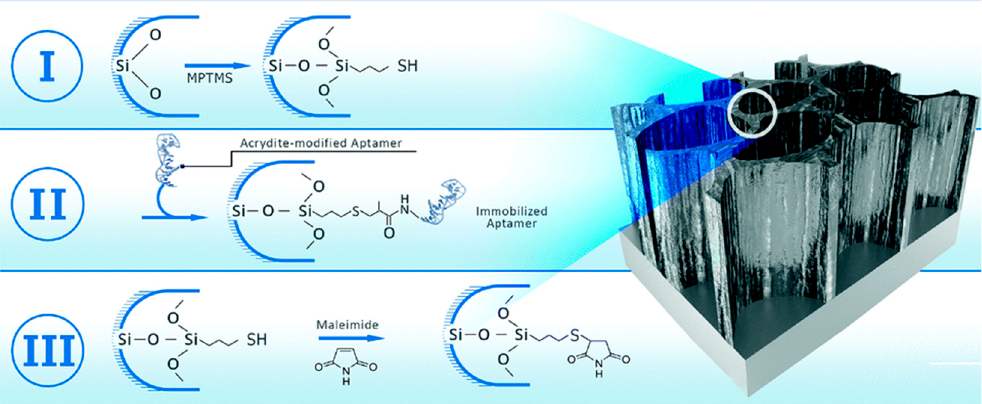
Figure 1. Three-step biofunctionalization process for aptamers immobilization onto PSiO 2 device. ( I ) Silanization with MPTMS via a thioether bond, ( II ) reaction with acrydite-modified Hemag1P aptamer via a thioether bond and ( III ) blocking of residual thiol groups with maleimide. Reproduced with permission from [56].